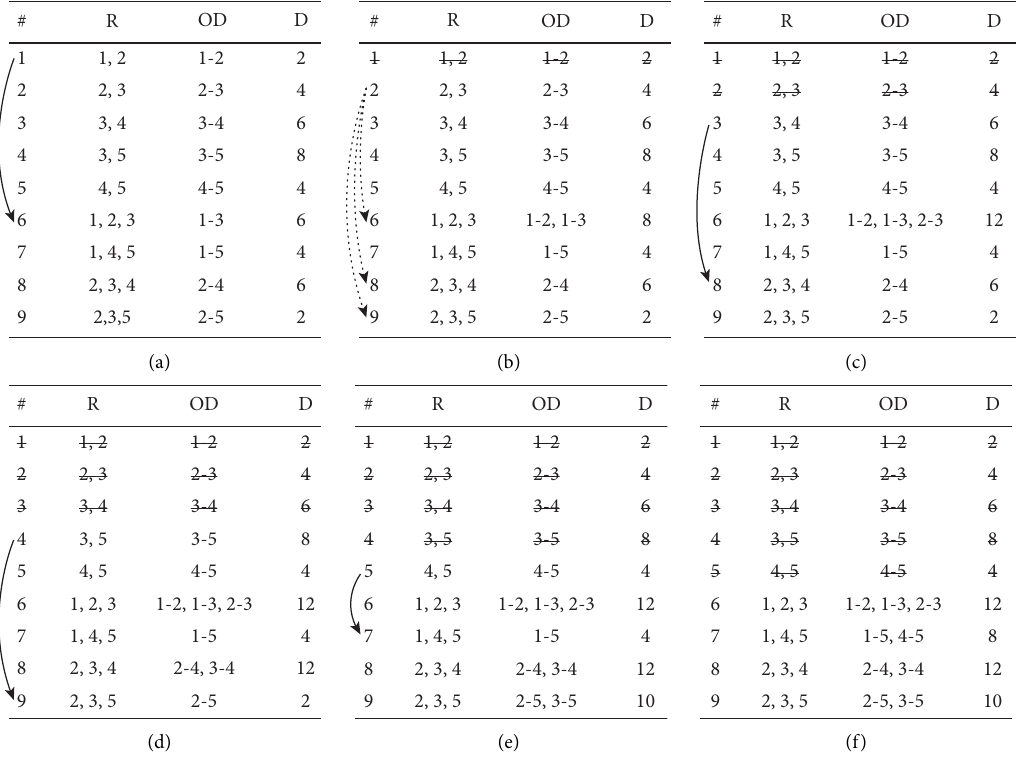
Figure 3: Illustration of the absorption procedure. (a) Route 1 ⟶ 6. (b) Route 2 ⟶ 6/8/9. (c) Route 3 ⟶ 8. (d) Route 4 ⟶ 9. (e) Route 5 ⟶ 7. (f) None. Table 2: Properties of five